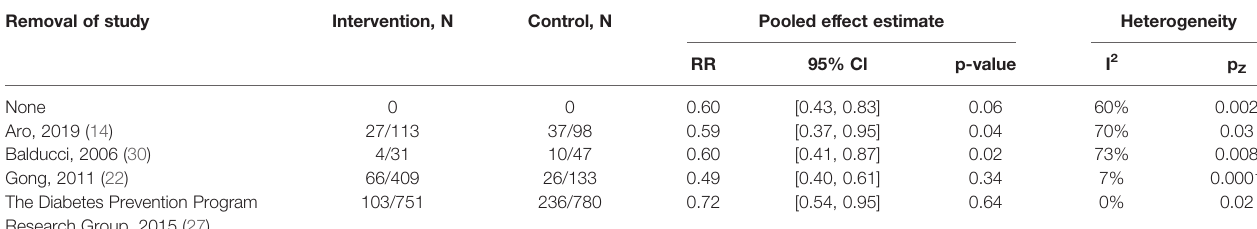
TABLE 2 | The sensitivity analysis outcomes of microvascular events. Removal of study